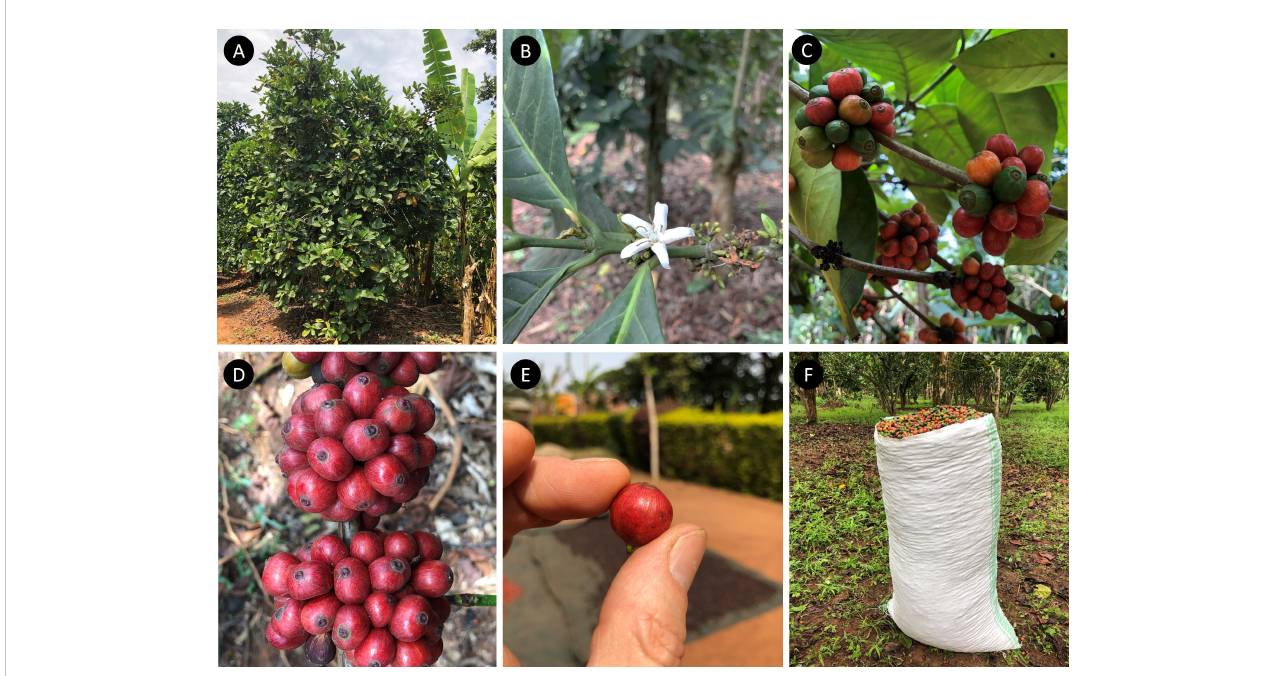
FIGURE 6 Coffea liberica var. dewevrei (excelsa coffee), cultivated in central Uganda. (A) Habit or farmed plant (tree), c. 5 m high, growing with banana; (B) Single fl ower (5-merous), old fl owers and fl ower buds; (C) Fruiting branches, with maturing fruits; (D) Fruiting branch, with tight axillary clusters; (E) Single fruit (cherry), c. 17 × 15 mm; (F) sack of fruit (cherry) from a single tree (c. 70